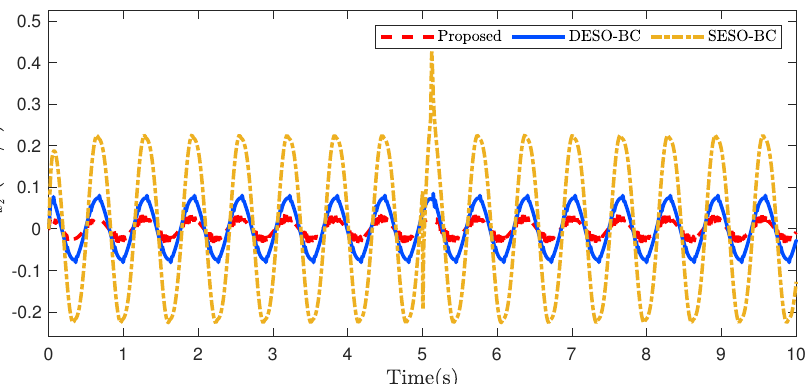
Figure 8. Angular velocity estimation performances of all control approaches in case of step refer- ence